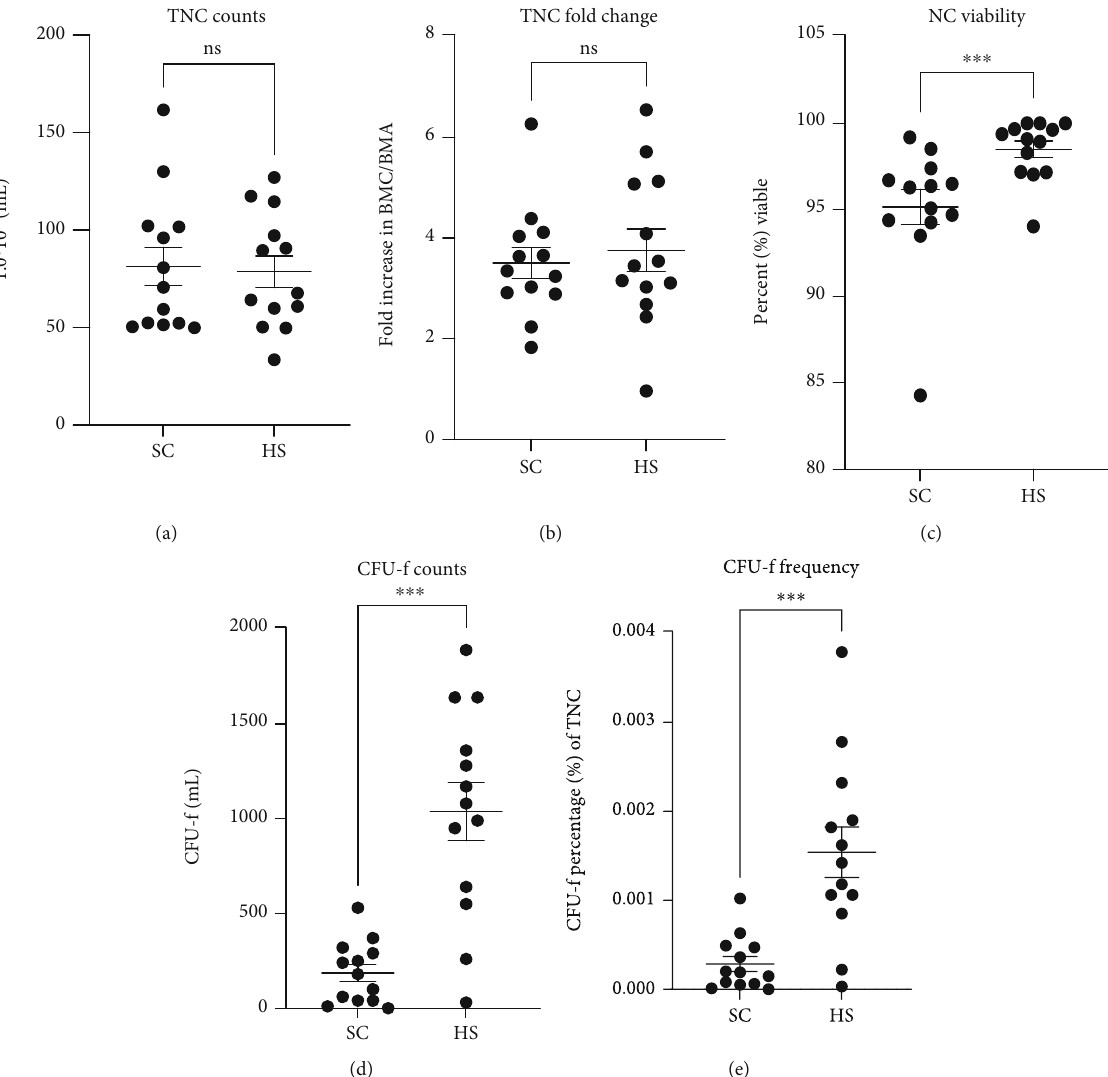
Figure 2: Comparison of BMC characteristics derived from 15% sodium citrate (SC) and 100 U/mL heparin sodium (HS) (Series 2): (a) total nucleated cell (TNC) count per milliliter, (b) fold concentration of TNC count/milliliter in BMC over initial BMA, (c) nucleated cell (NC) viability, (d) colony-forming units with fi broblast morphology (CFU-f) counts per milliliter, and (e) frequency of CFU-f amongst the TNC population. Graphs display the population mean and standard error of the mean. ns: not signi fi cant, ∗ P < 0 : 05 , ∗∗ P < 0 : 01 , and ∗∗∗ P < 0 : 001